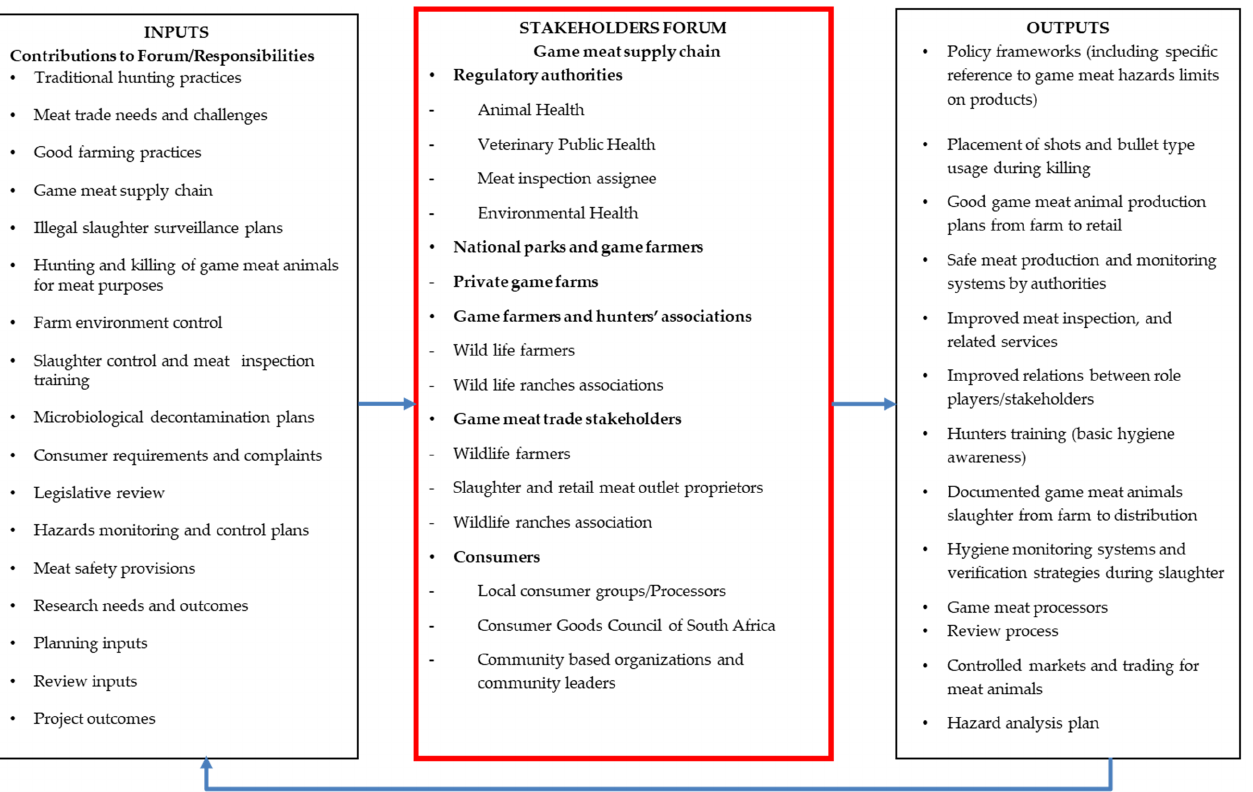
Figure 2. Theoretical model for small wild ungulate meat animal slaughter in South Africa.